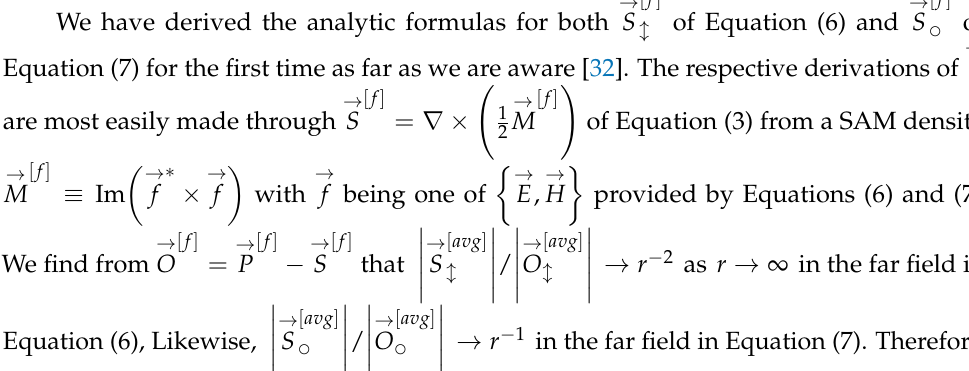
Figure 1. ( a ) Decomposition of a Poynting vector P energy flux S systems. On the origin lies a primary electric point dipole represented by its unit vector ˆ p . ( c ) A linear dipole ˆ p tapered cylindrical surface designating higher values for the degree of circular polarization (DoCP). ( d ) A circular dipole ˆ p cone of higher values of DoCP.